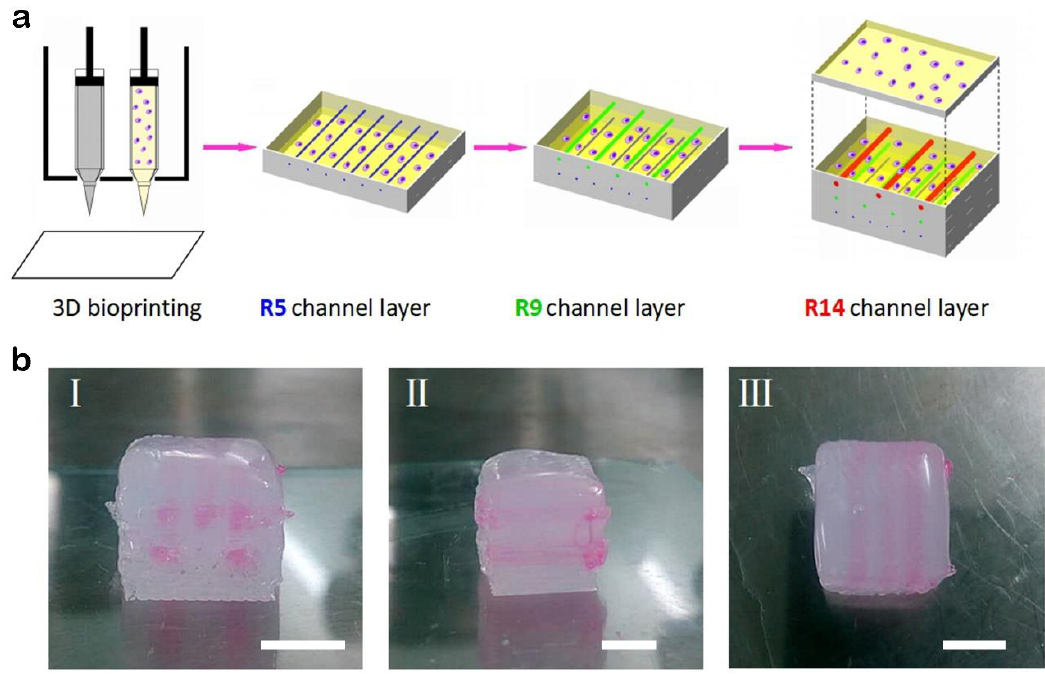
Figure 5. A multilevel channel structure printed by this method. ( a ) Schematic illustration showing the procedure of biofabricating thick tissues with hollow channels of three different diameters: broad channels (radius: 1.4 mm), medium channels (radius: 0.9 mm), and narrow channels (radius: 0.5 mm). ( b ) Actual pictures of a multilevel channel structure: (I) front view, (II) side view, (III) top view. (Scale bar: 5 mm).